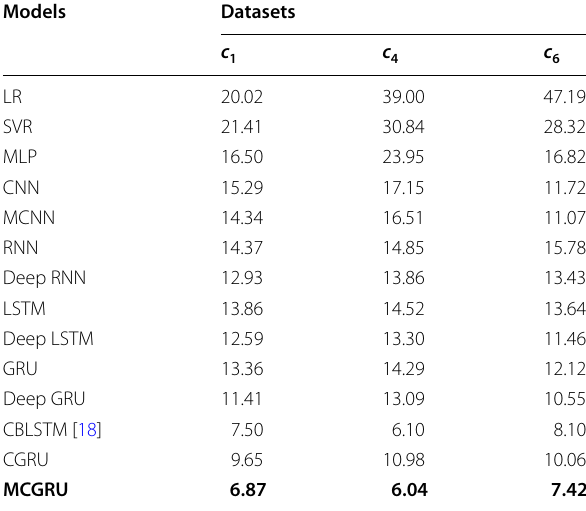
Bold face indicates the best